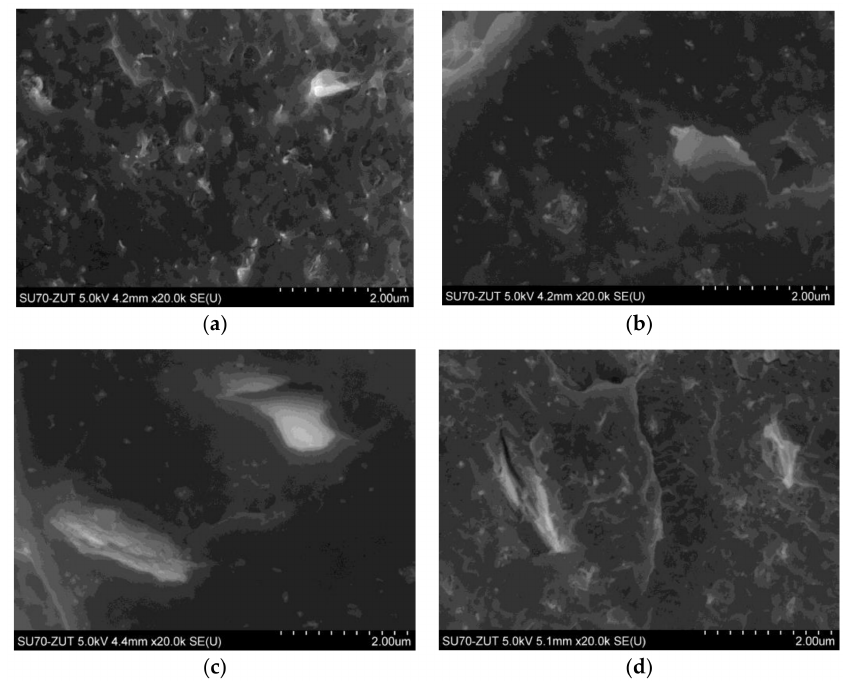
Figure 2. SEM images of: ( a ) LDPE/5 wt. % (MWCNTs:GNPs 3:1); ( b ) LDPE/3 wt. % (MWCNTs:GNPs 3:1); ( c ) LDPE/5 wt. % (MWCNTs:GNPs 1:1); and ( d ) LDPE/3 wt. % (MWCNTs:GNPs